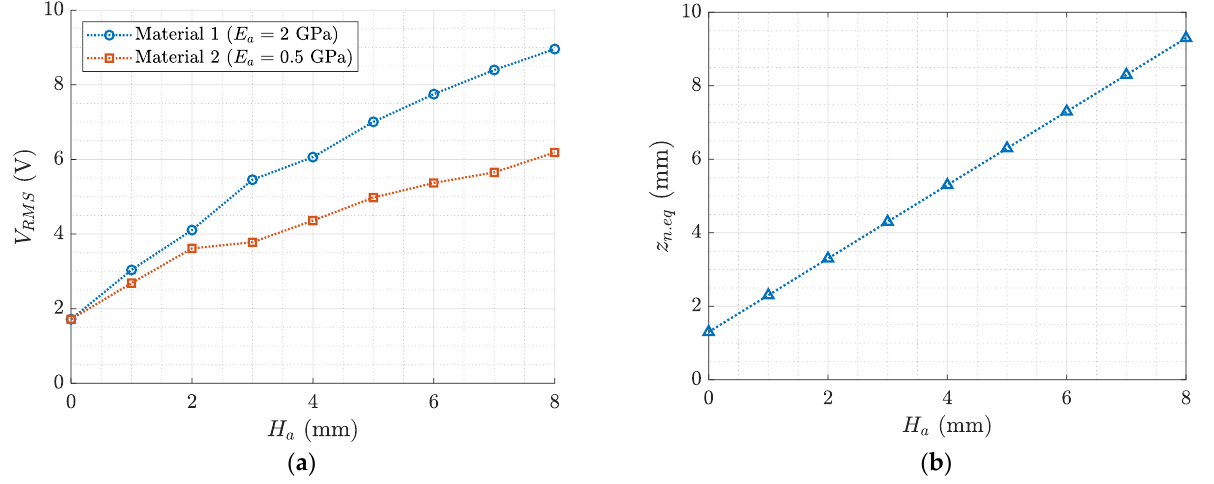
Figure 17. ( a ) RMS value of OCV vs. thickness 𝐻 of the interposed layer and the Young’s modulus 𝐸 of the interposed layer; ( b ) distance 𝑧 𝑛, of the center of the PE patch from the neutral axis.